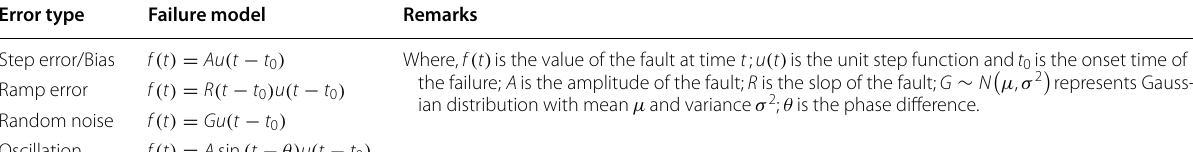
Table 2 Mathematical models of faults (Bhatti and Ochieng 2007)